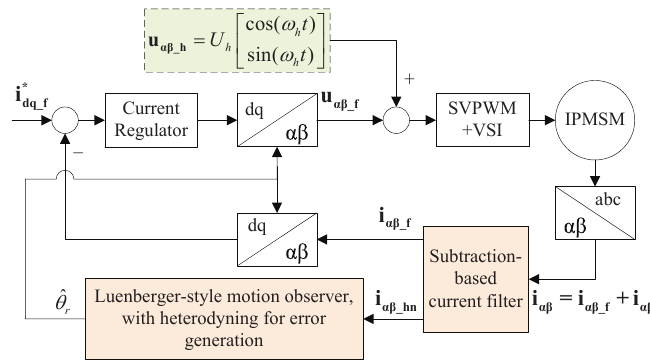
Figure 1. High-frequency injection and rotor position